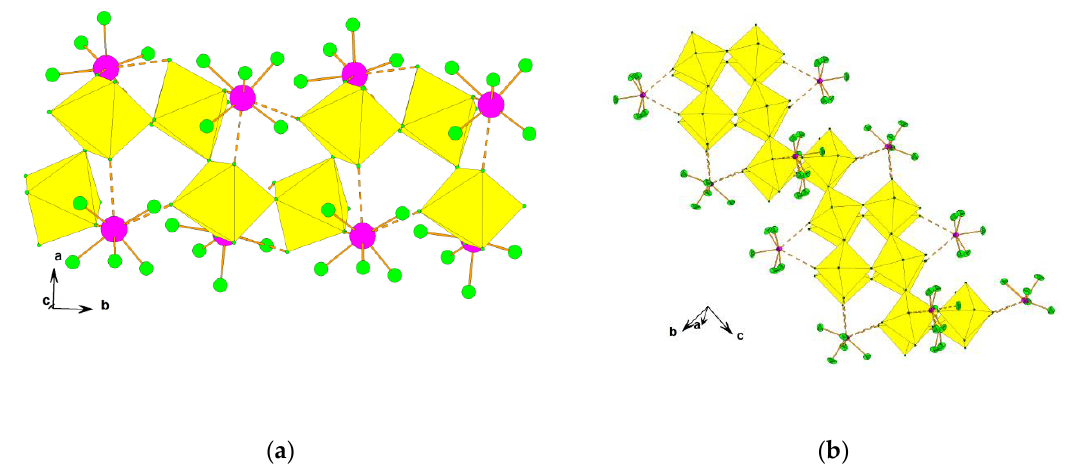
Figure 4. ( a ) Part of the ([TiF 5 ] − ) ∞ chain in [XeF 5 ][TiF 5 ]; ( b ) Part of the infinite ([Ti 3 F 13 ] − ) ∞ column in [XeF 5 ][Ti 3 F 13 ]. Ref. [35]; reproduced by permission of The Royal Society of Chemistry (RSC) on behalf